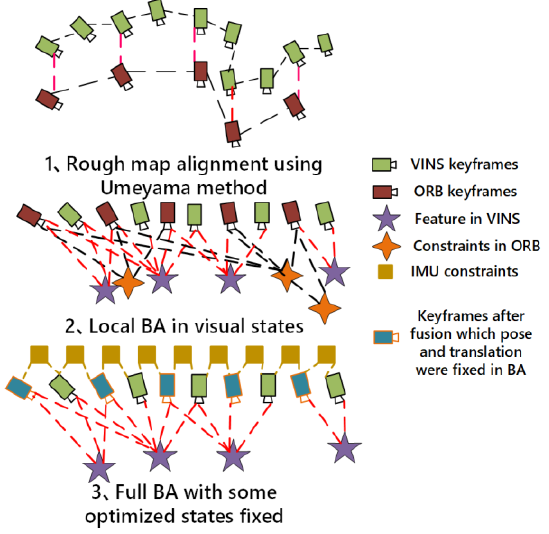
Figure 5. The illustration of data fusion process between the feature-based map and the optical map. Then, the transfer matrix between two co-view frames in the feature-based map is substituted into the corresponding relationship in optical flow method for optimization.